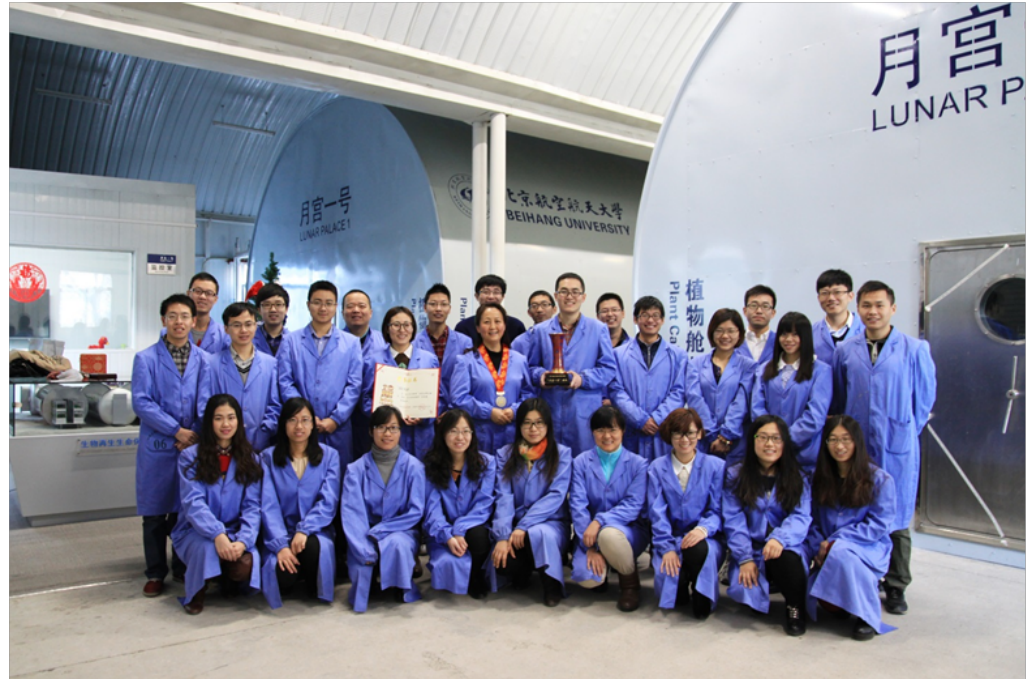
Figure 8. Lunar Palace 1 research team, Beihang University, Beijing, China. Prof. Hong Liu, team lead is at the center of the photo, second row wearing a red ribbon and medal. The Lunar Palace 1 supported three humans for 105 days using bioregenerative life support technolo- gies, with crops grown under LEDs providing the air, water, and most of the food. Photo courtesy of Hong Liu, Beihang University.